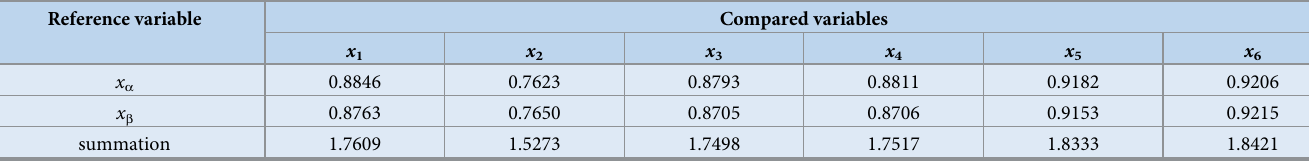
Table 4. Gray correlation of phase change fracturing of liquid CO 2 in coal rocks. Reference